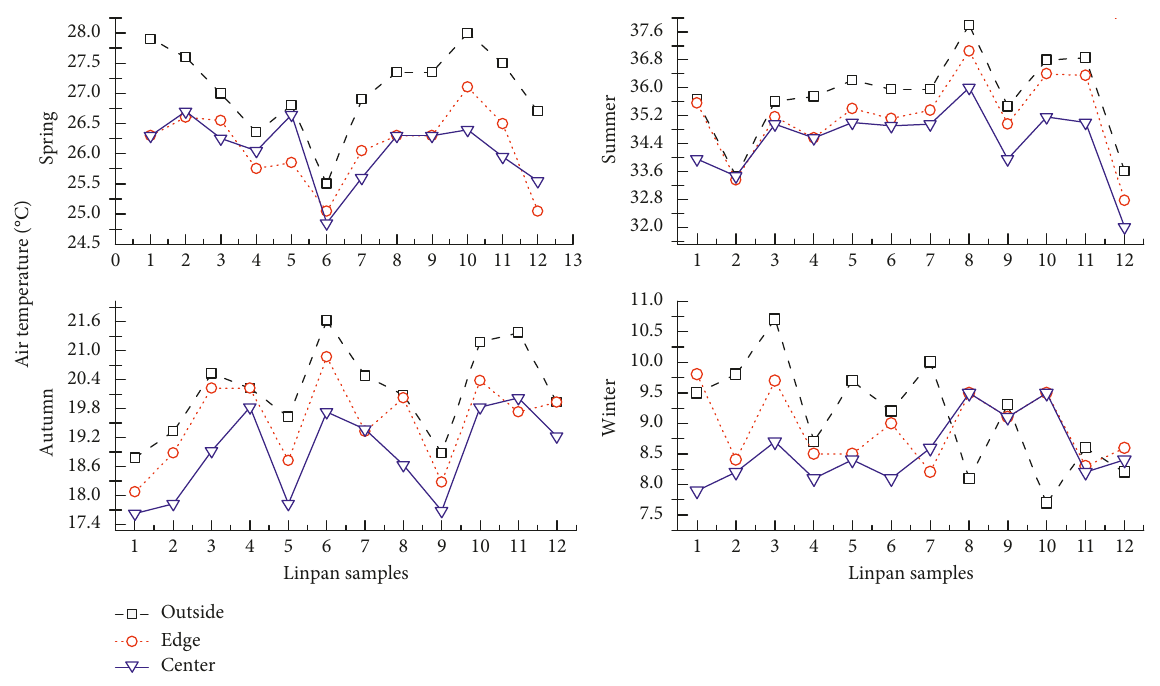
Figure 4: The seasonal air temperature of Linpan